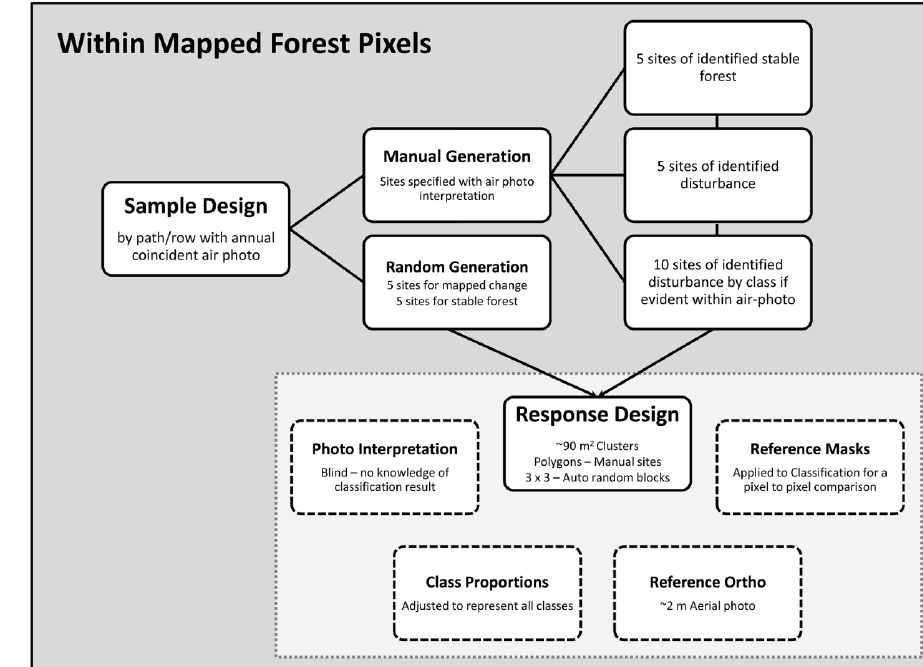
Figure 3. Accuracy assessment workflow based upon “good practices” synthesized in Olofsson et al. , 2014